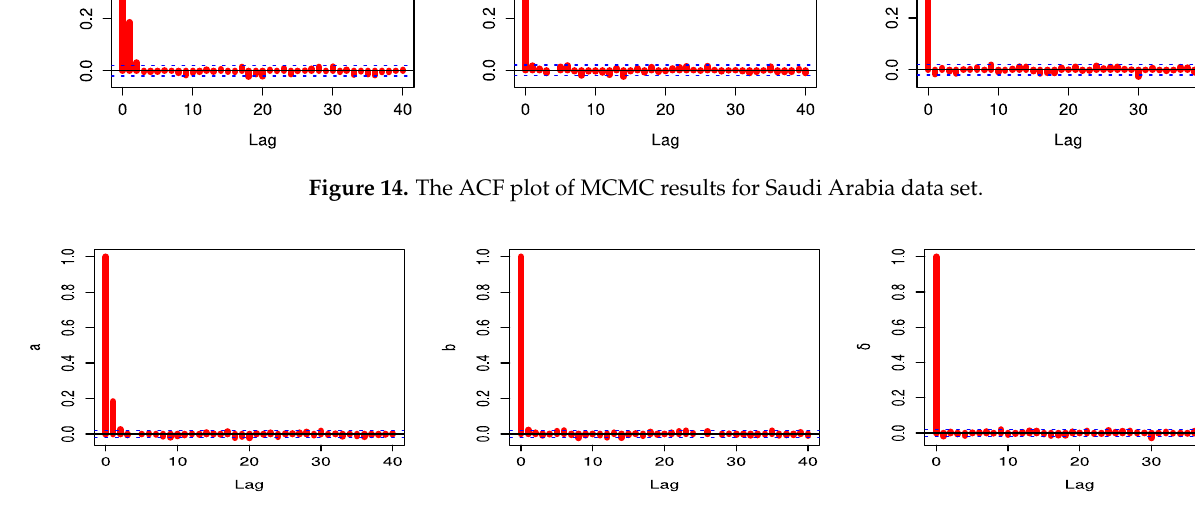
Figure 15. ACF plot of MCMC results for the United Kingdom data set.